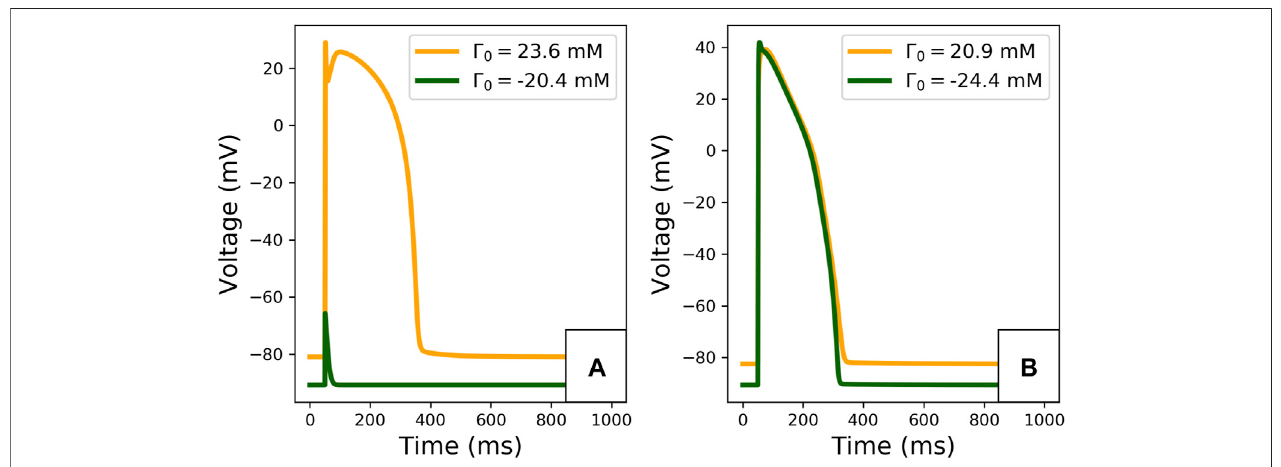
FIGURE 5 | Limit cycle APs for extreme initial conditions for the TTP06 model (A) and for the ORd-CiPA model (B) . Extreme Γ 0 values covering approximately 44 mM are computed from the extreme [ K + ] i and [ Na + ] i observed in human ventricular models, as reported in Figure 4 .